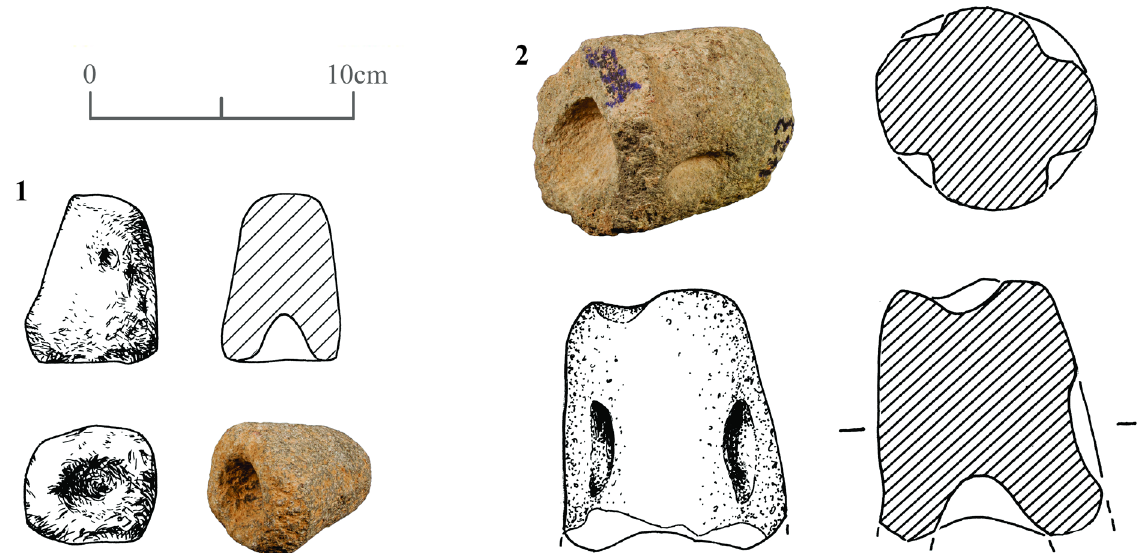
Figure 3. Ground stone drill sockets from the Iron Age I levels at Tel Dan. 1. Registration number 23890, Locus 7151, Serial number 257, upper diameter 34 mm, lower diameter 50 mm, height 65 mm, weight 198 g, complete preservation, Area and phase B9-10, Stratum V. 2. Registration number 23450/10, Locus 7065, Serial number 423, upper diameter 66-80 mm, lower diameter 80-85 mm, height 96 mm, weight 970 g, broken preservation, Area and phase B9-10, Stratum